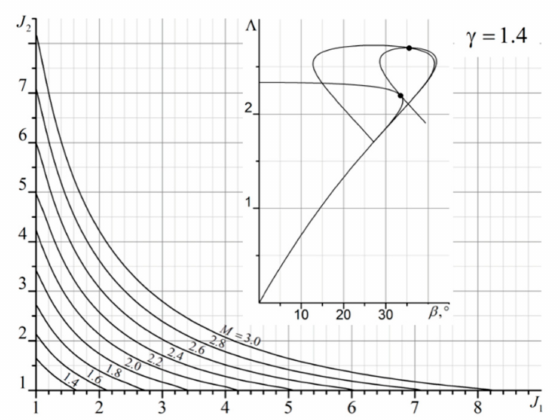
Figure 5. The boundary for solving the problem of regular